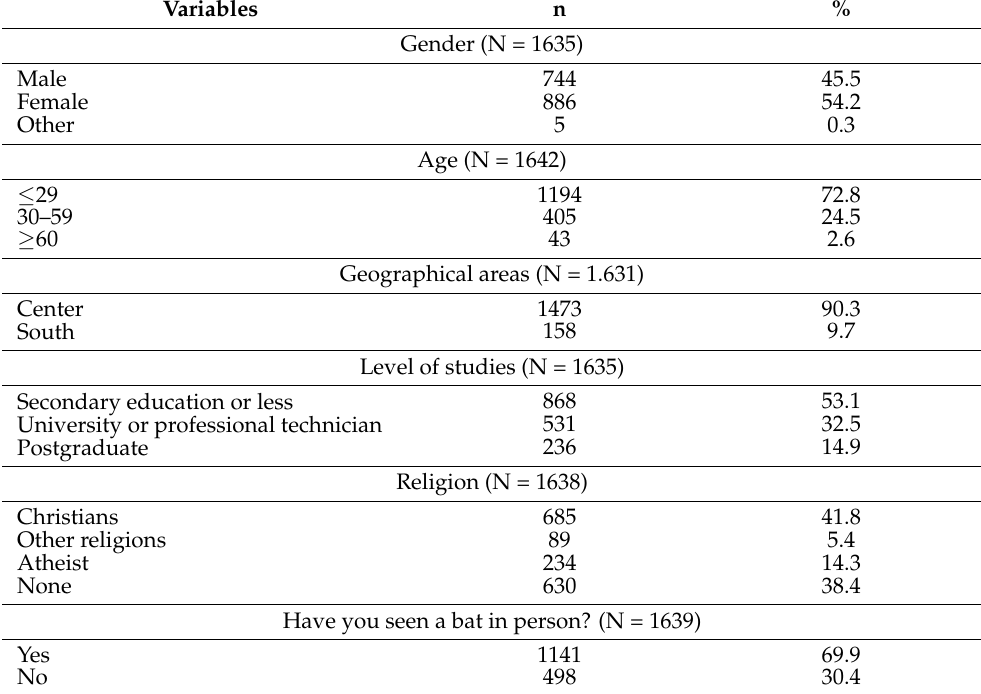
Table 1. Sociodemographic characteristics of the participants. Variables n